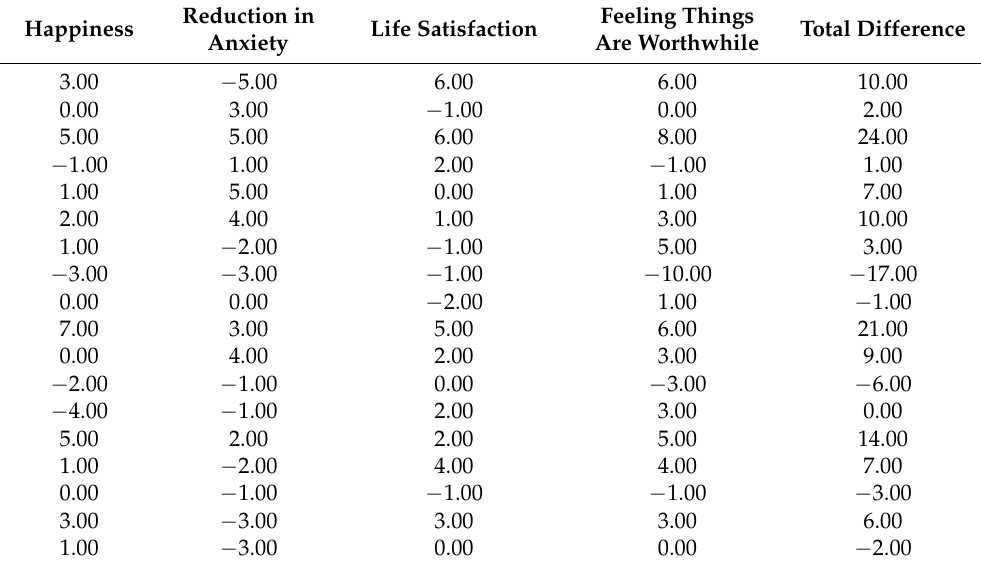
Table 2. Differences between scores on the Office for National Statistics Personal Wellbeing Scale upon entry and exit to the service. Reduction in Feeling Happiness Life Satisfaction Anxiety